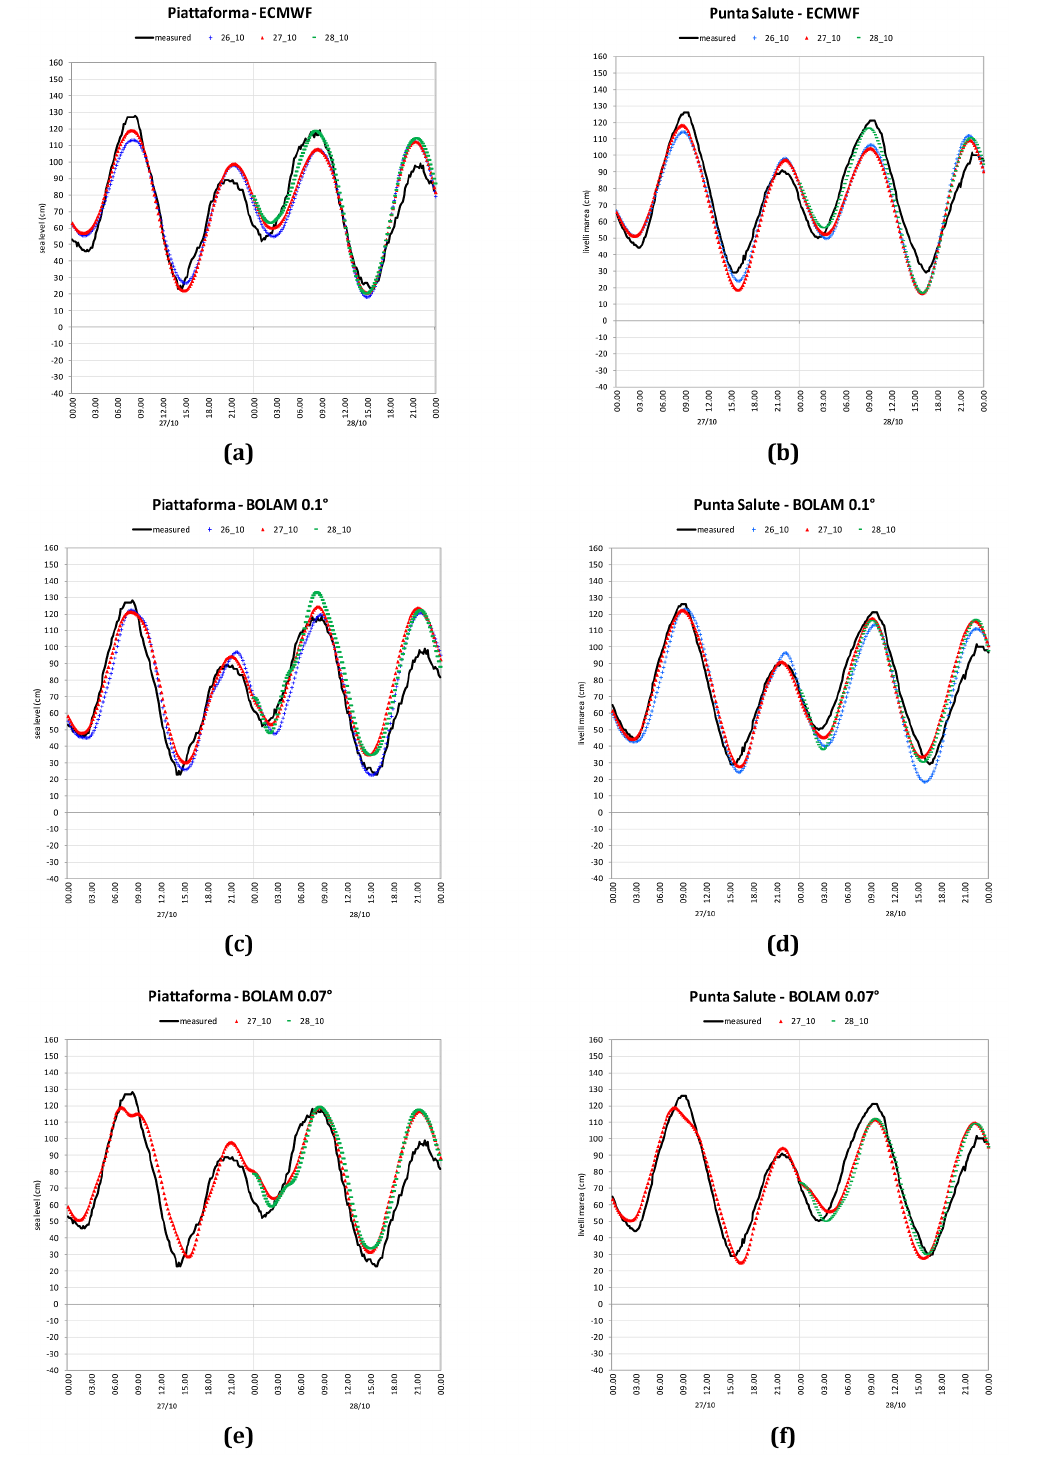
Figure 14. Comparison for IOP16 between the SHYFEM forecasts and the sea level observations registered at Piattaforma and Punta della Salute. Time in CET (UTC + 1). Meteorological forcing by: ( a and b ) ECMWF IFS forecasts from 26 to 28 October; ( c and d ) 0.1 ◦ BOLAM forecasts from 26 to 28 October; ( e and f ) 0.07 ◦ BOLAM forecasts from 27 to 28